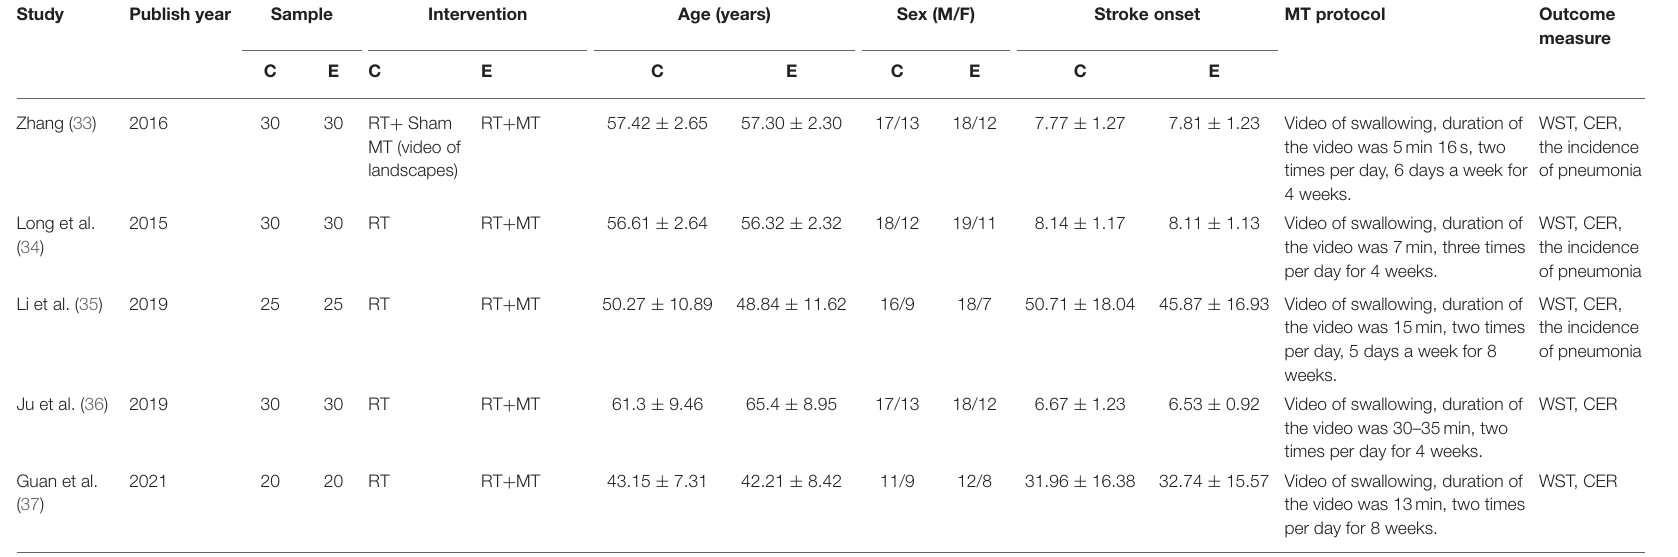
TABLE 1 | Characteristics of the studies included in this